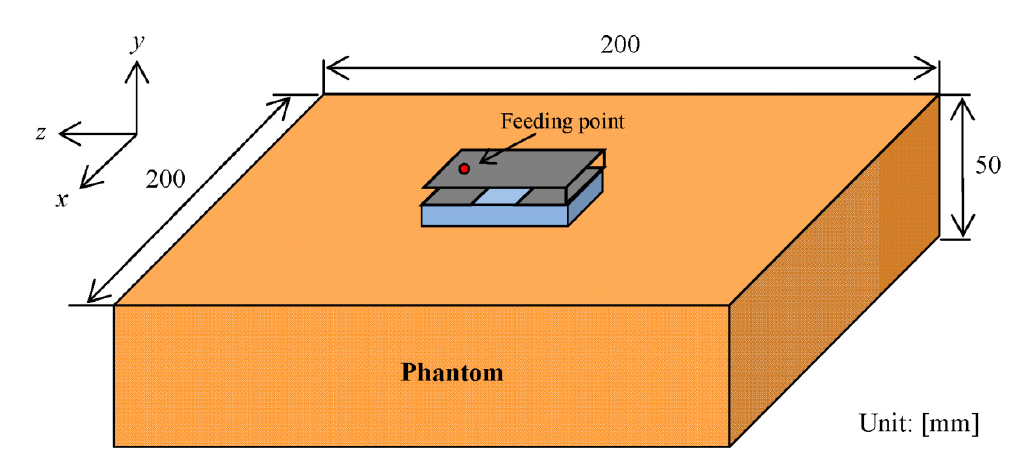
Figure 5. Proposed antenna on a part of chest